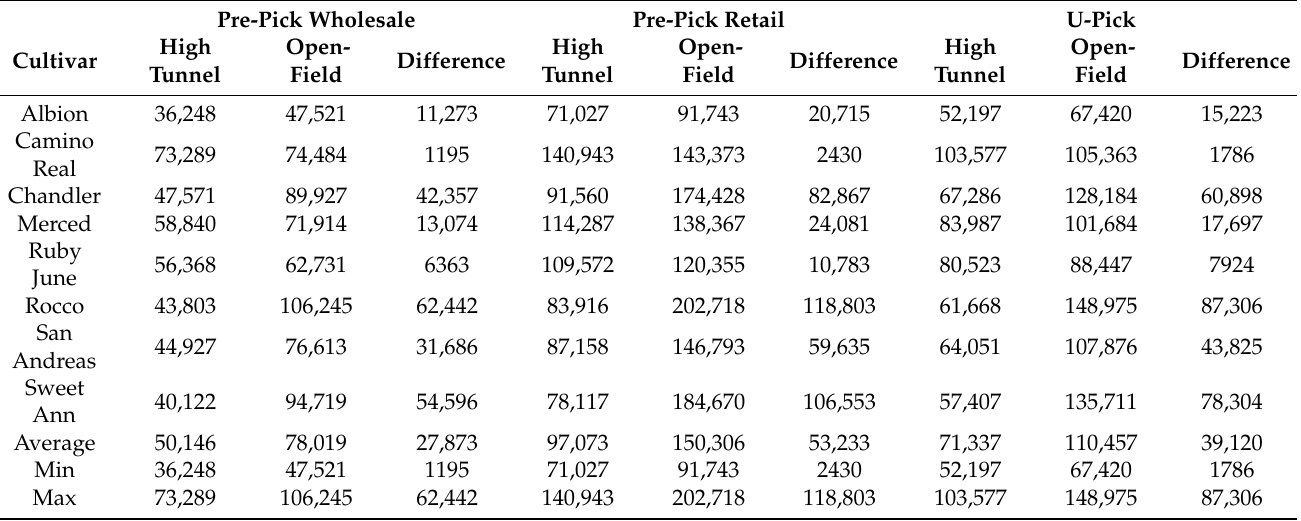
Table A1. Strawberry gross revenues (estimated yield ∗ estimated price) in USD per hectare by cultivar and marketing strategy in the high tunnel and open-field